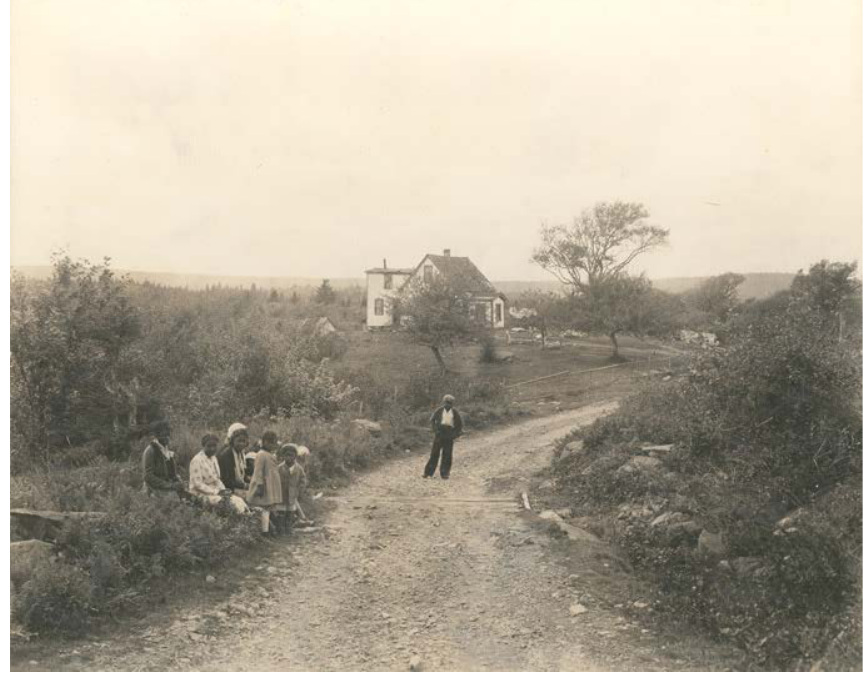
Figure 4. House at North Preston, with a group of children in the foreground. October 1934. Nova Scotia Archives.